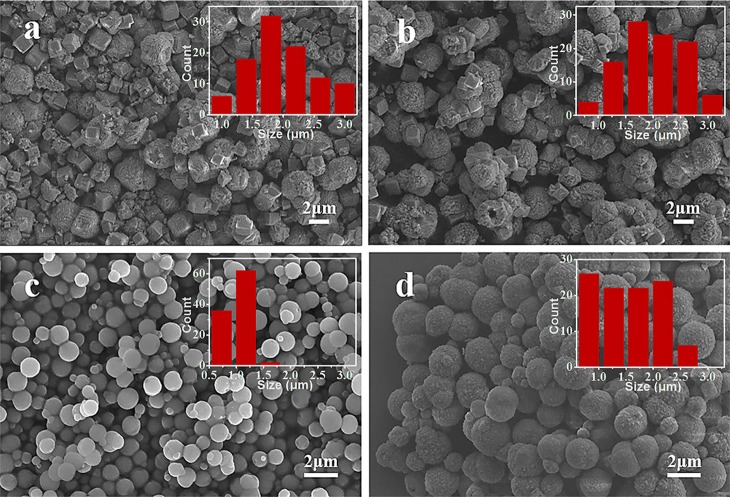
SEM images of MnCO3 prepared at different concentrations of NH4HCO3 solution. (a) 0.09 M; (b) 0.18 M; (c) 0.36 M; (d) 0.54 M. The inset shows the size distribution of these particles.